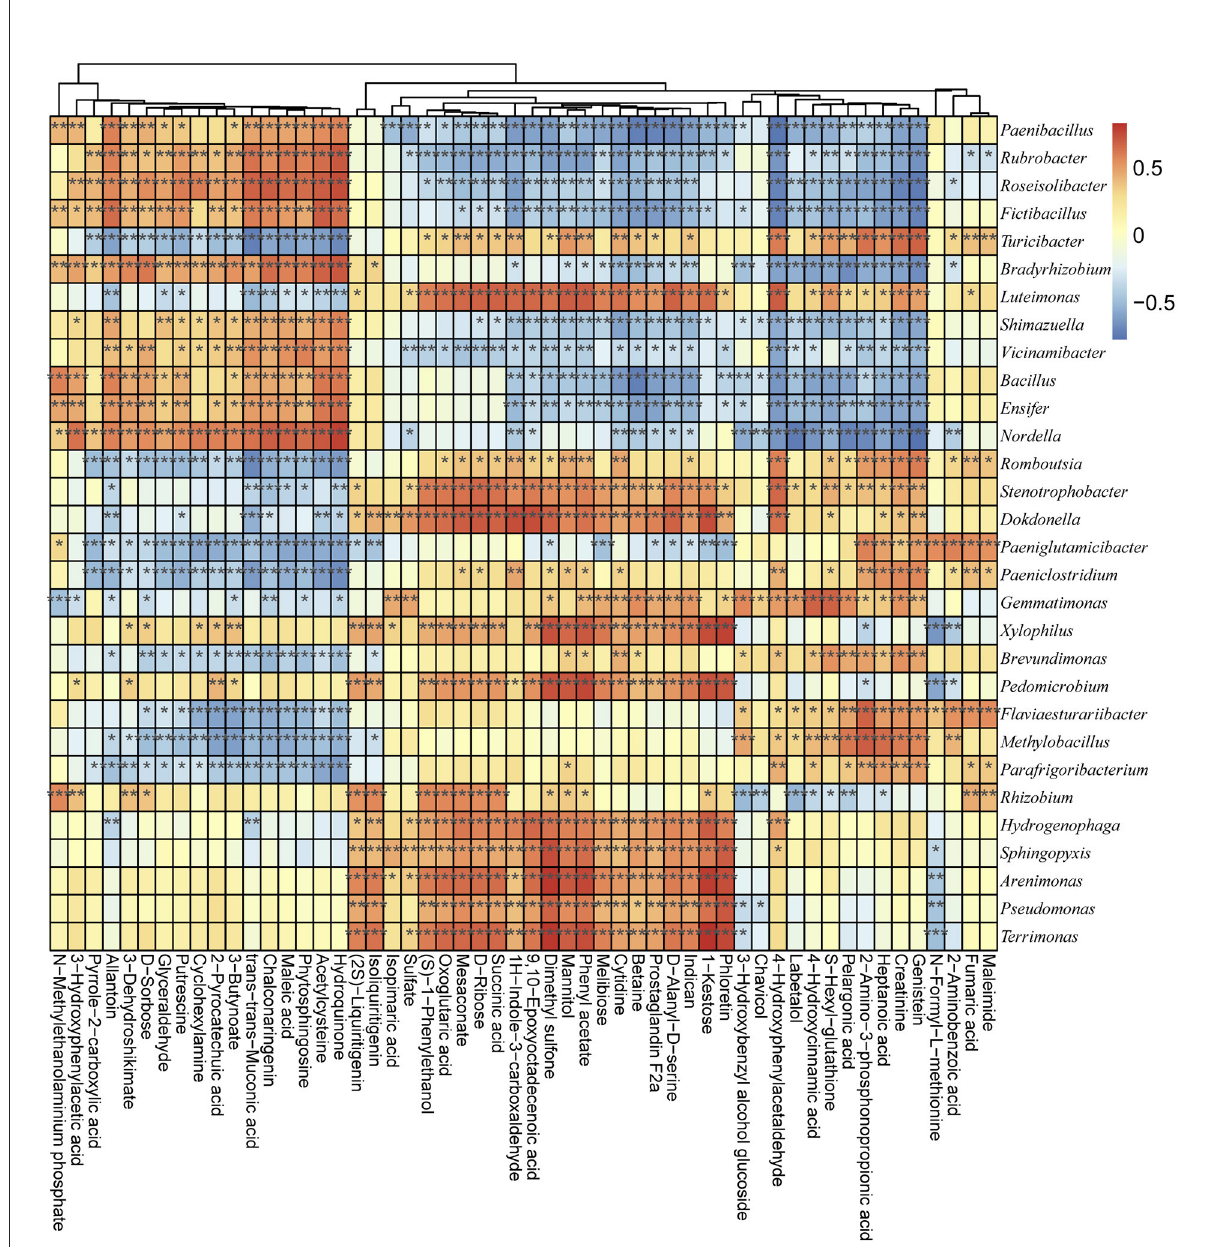
FIGURE5 Associations between metabolic products and microbial communities according to Spearman’s correlation algorithm. The horizontal axis presents the metabolic products, whereas the vertical axis presents the microbial communities at the genus level. Red and blue indicate positive and negative correlations, respectively. * P < 0.05 and |R| > 0.7, ** P < 0.01 and |R| > 0.7, and *** P < 0.001 and |R| >